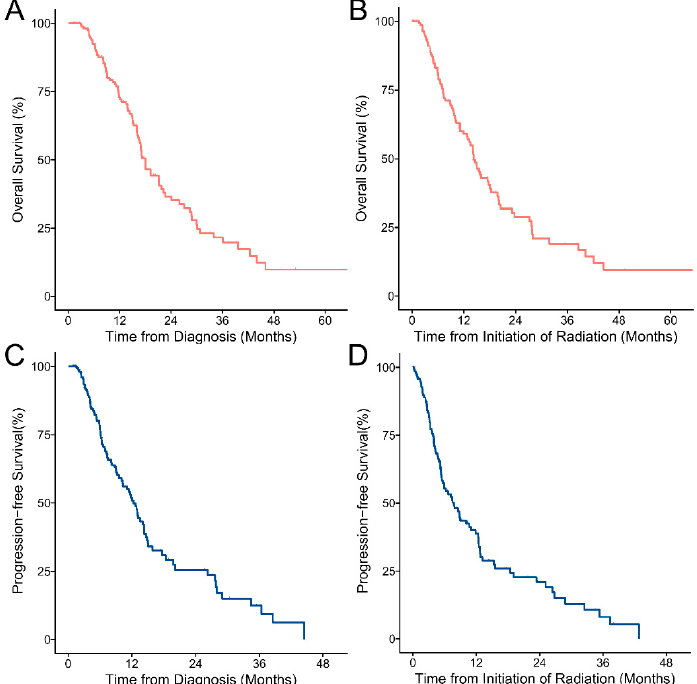
Figure 2. Kaplan–Meier plots of overall survival (OS) and progression-free survival (PFS) of the entire cohort. ( A ) OS measured from the date of diagnosis; ( B ) OS measured from radiotherapy; ( C ) PFS measured from diagnosis; ( D ) PFS measured from radiotherapy.